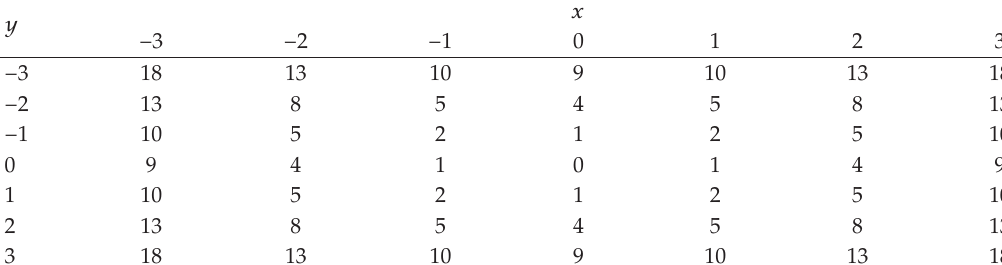
Table 4: A 3D positive data